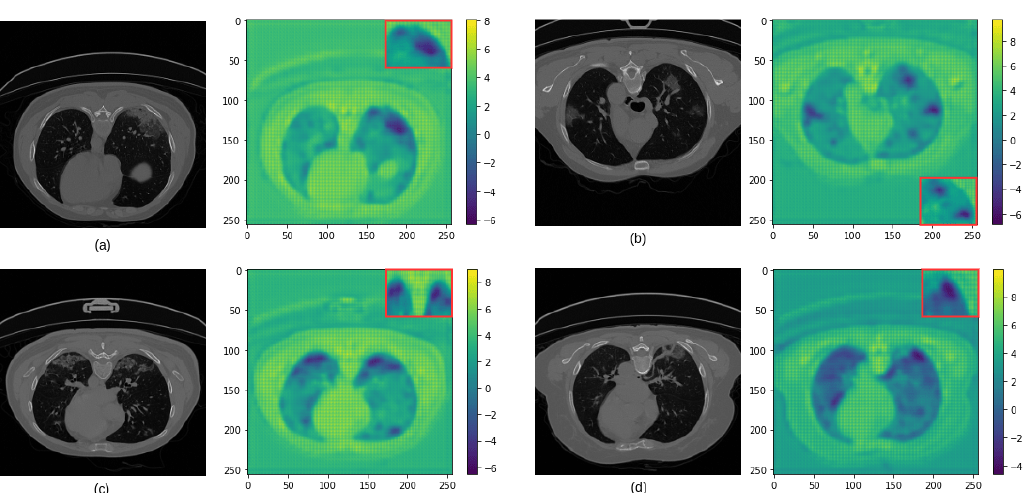
Figure 11. The role of LPDGC in capturing small COVID-19 lung infections from CT images (represented in dark blue). ( a – d ) present examples of COVID-19 infection in CT images ( left ) and the corresponding Heatmaps ( right ). Here, the red box presents a zoom-in visualization of the infected